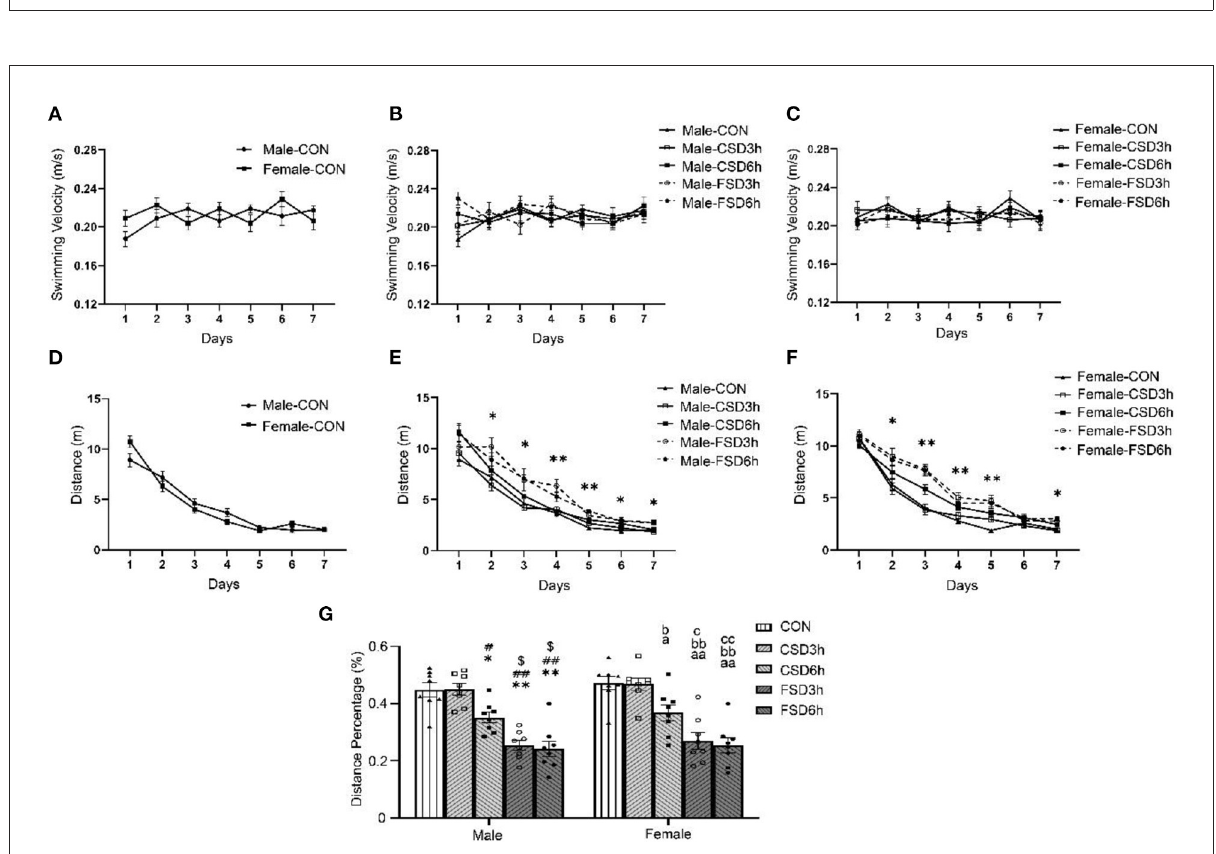
FIGURE4 Results of the Morris water maze test (16 mice were tested per treatment group, including 8 males and 8 females). (A–G) The velocity and distance swam covered during the 7 days of training, and the distance percentage in the target quadrant for space exploration are depicted graphically. Longer distance swam was regarded as a reduction in learning ability, while lower percentages of distance swam were regarded as a reduction in memory ability. (A) CON speed, (B) Male speed, (C) Female speed, (D) CON distance swam, (E) Male distance swam, (F) Female distance swam, and (G) distance percentage. * P < 0.05 and ** P < 0.01 vs. Male CON group; # P < 0.05 and ## P < 0.01 vs. Male CSD3h group; $ P < 0.05 vs. Male CSD6h group; a P < 0.05 and aa P < 0.01 vs. Female CON group; b P < 0.05 and bb P < 0.01 vs. Female CSD3h group; c P < 0.05 and cc P < 0.01 vs. Female CSD6h